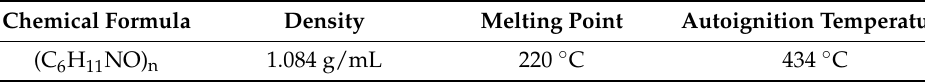
Figure 2. CFRTP chopped sheet: ( a ) macro-structure of the chopped CFRTP sheet from the top view; ( b ) microstructure of the cross-section of the CFRTP chopped sheet; ( c ) carbon fiber diameter. Table 2. Nylon 6 properties.